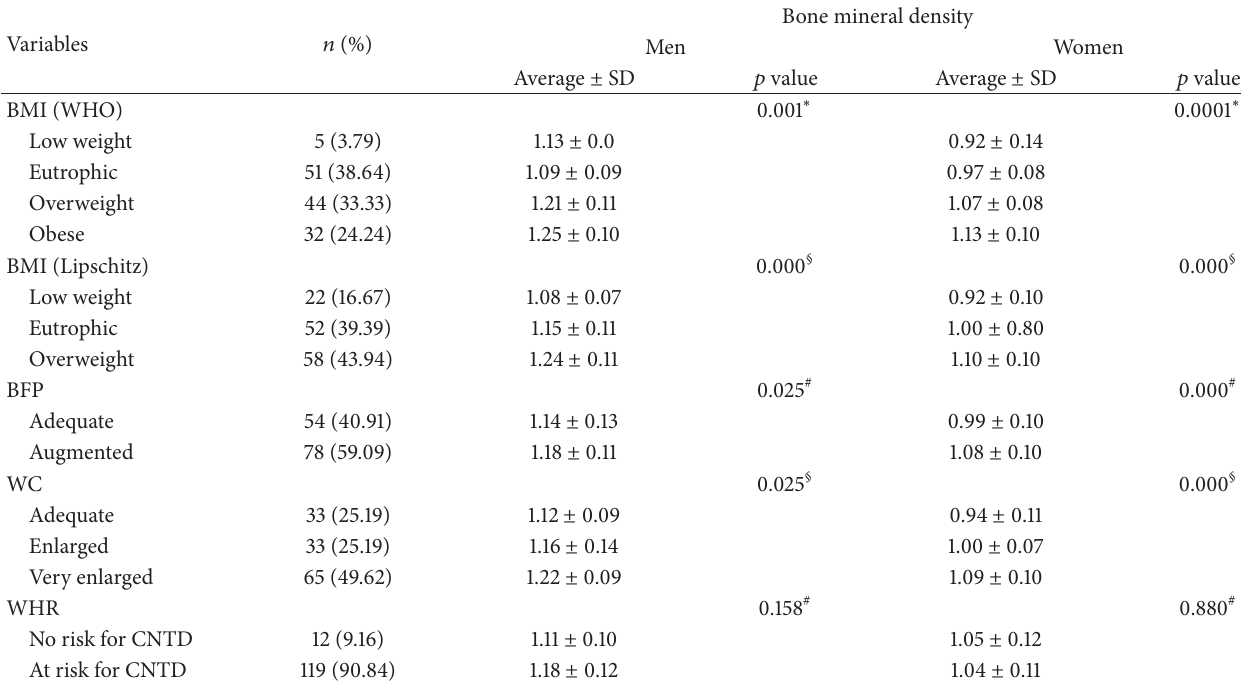
Table 3: bone mineral density in the elderly, per gender, and association with anthropometric and body composition variables. Goiˆania, GO, 2009. 𝑛 = 132